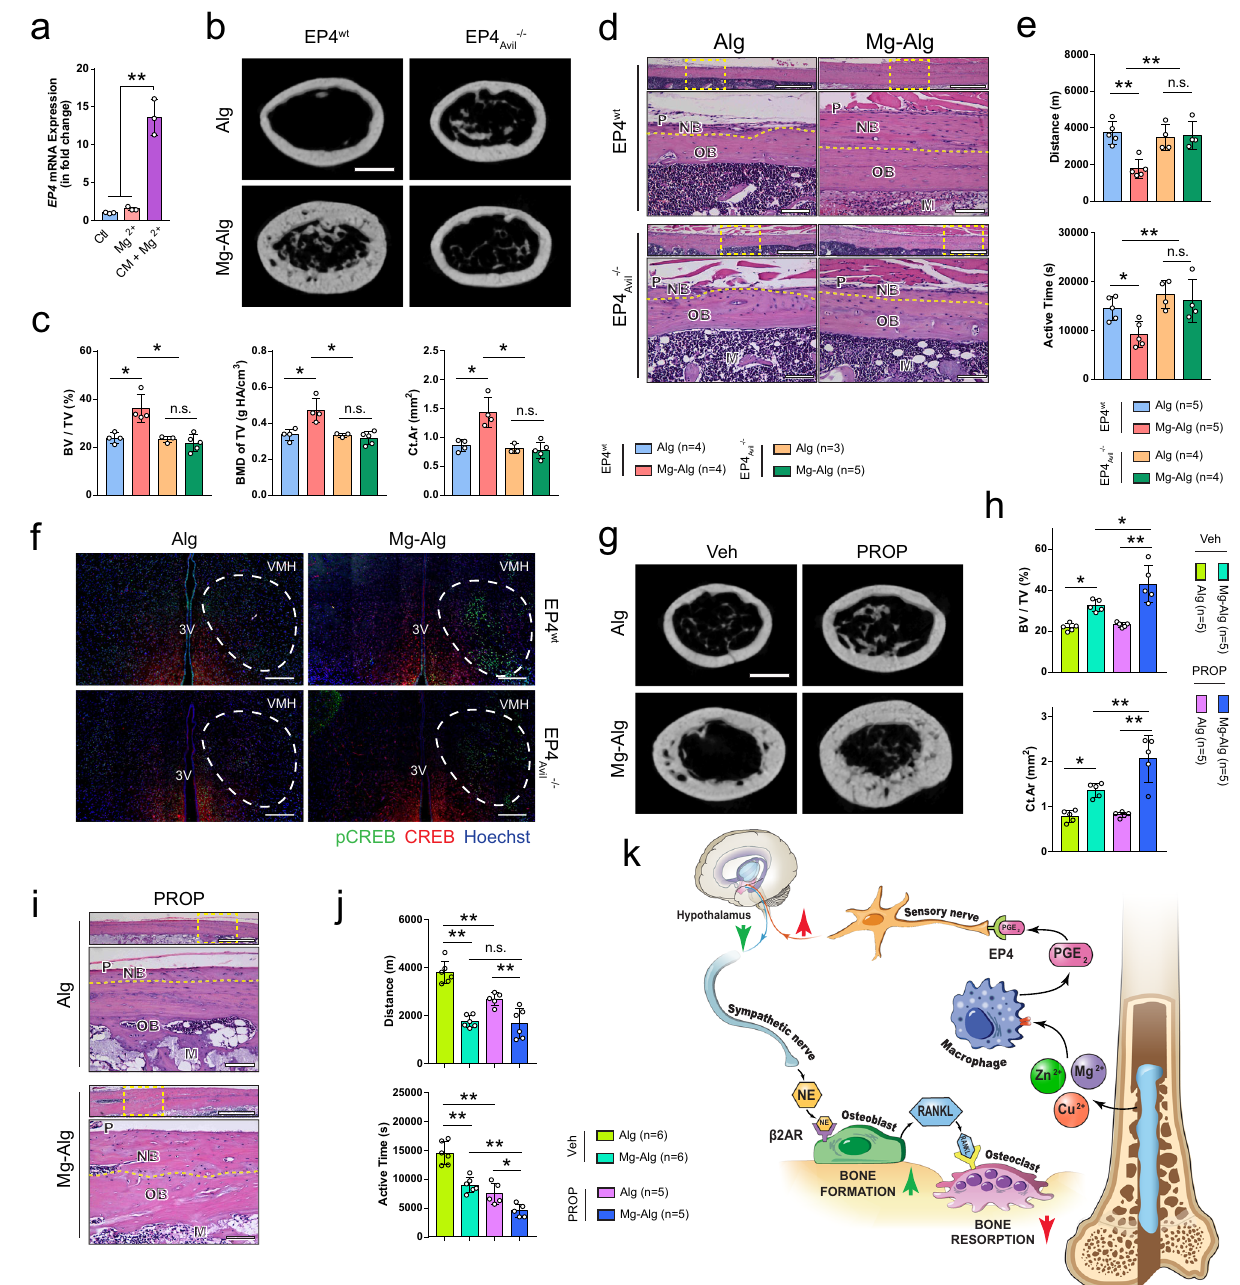
Fig. 6 Knockout of PGE 2 receptor 4 (EP4) in sensory nerves abolishes divalent cation-induced bone formation. a EP4 expression in DRG neurons stimulated by 10 mM Mg 2 + with or without the conditioned medium from Mg 2 + -treated macrophages ( n = 3). Reconstructed µ CT images ( b , scale bars = 1 mm), corresponding measurements ( c ), and representative H&E staining images ( d ) showing the new bone formation in EP4 wt mice or EP4 Avil − / − mice ( n = 3). Lower images are high-resolution versions (scale bars = 100 µ m) of the boxed regions in the upper images (scale bars = 500 µ m). e The running- wheel activity of EP4 wt or EP4 Avil − / − mice at week 4 postoperatively. f The phosphorylation of CREB in the VMH of EP4 wt or EP4 Avil − / − mice at week 1 postoperatively ( n = 3, scale bars = 200 µ m). Reconstructed µ CT images ( g , scale bars = 1 mm), corresponding measurements ( h ), and representative H&E staining images ( i ) showing the new bone formation in mice injected with vehicle (Veh) or propranolol (PROP) Lower images (scale bars = 100 µ m) are high-resolution versions of the boxed regions in the upper images (scale bars = 500 µ m). j The running-wheel activity of mice injected with vehicle or propranolol at week 4 postoperatively. k Schematic diagram showing the fi ndings of this study. The divalent cations triggered the production of PGE 2 from macrophages, which activated the EP4 at the sensory nerve to tune down sympathetic tones via the CREB signaling in the VMH, resulting in increased osteogenesis and decreased osteoclastogenesis in the periosteum. Data are mean ± s.d. * P < 0.05, ** P < 0.01 by one-way ANOVA with Tukey ’ s post hoc test ( a , c , e , h , j ). Source data are provided as a source data fi le.